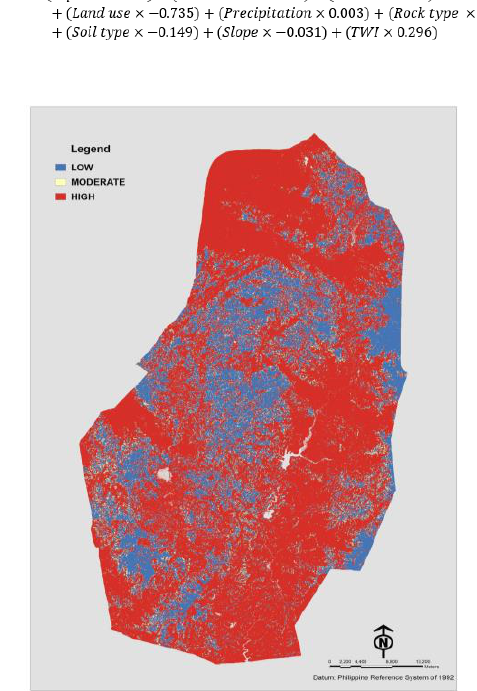
Figure 5. Logistic regression generated map.